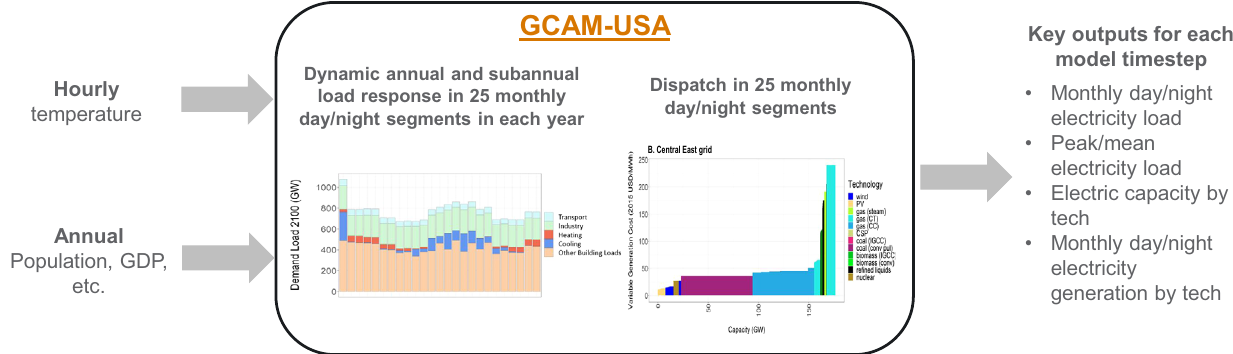
Fig. 5 GCAM-USA Advances. Conceptual diagram showing new advances made to GCAM-USA for the